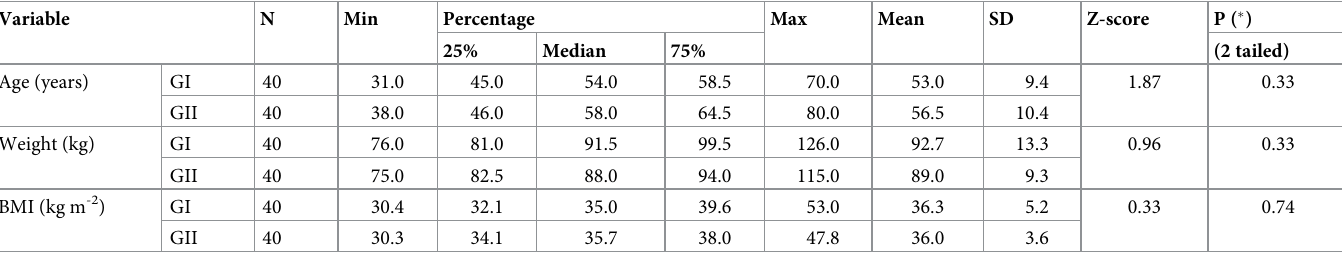
Table 1. Demographic data: Age, weight and body mass